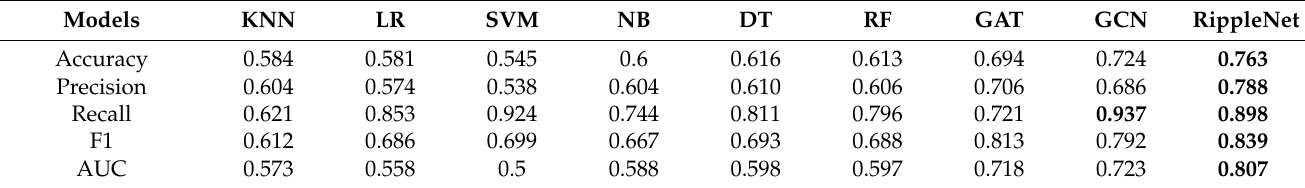
Table 12. Performance comparison of the recommendation model based on RippleNet with 8 contrast